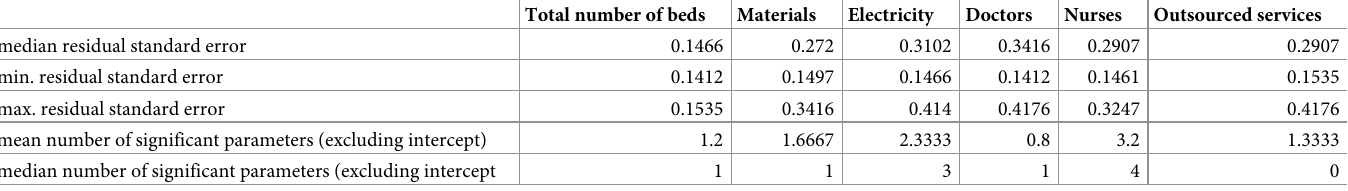
Table 4. Comparison of adjustment two-factor translog function by explanatory